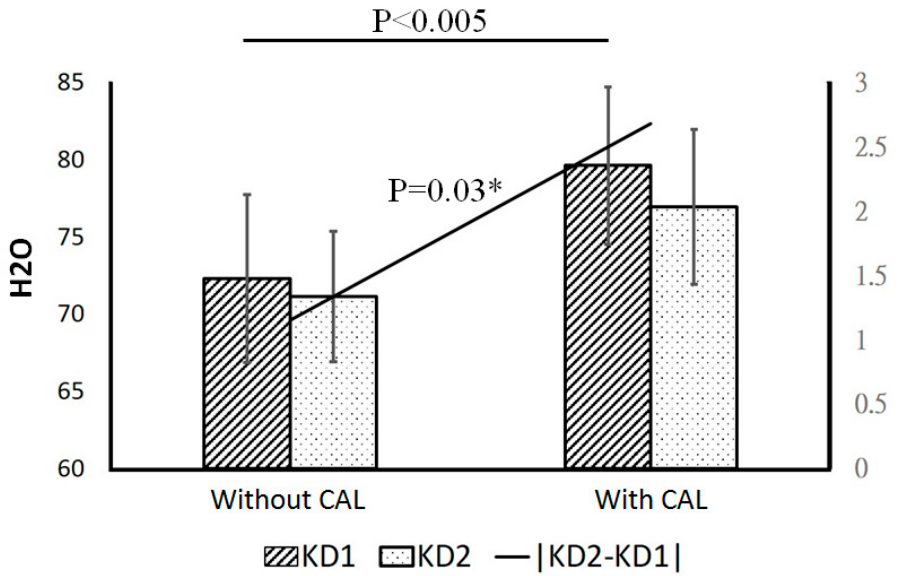
Figure 3. Relationship between coronary artery lesions (CAL) and relative H2O concentration in Kawasaki disease (KD). The relative water concentration was significantly higher in KD with CAL formation (N = 9) than without (N = 24) ( p < 0.005) in the KD1 stage. The difference between KD1 and KD2 relative H 2 O concentration levels also demonstrated significant differences with regard to CAL formation ( p = 0.03). (The left y -axis was for the parameters corresponding to different groups, the right y -axis was for the difference between KD1 and KD2). KD1, within one day before IVIG